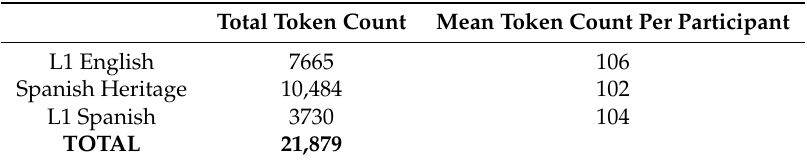
Table 5. Distribution of token counts per L1 group, and mean token count per participant.